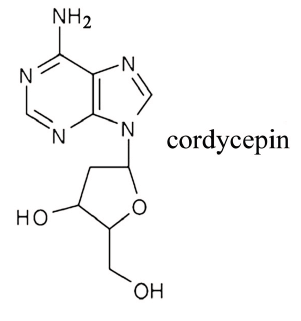
Figure 1. Chemical structure of